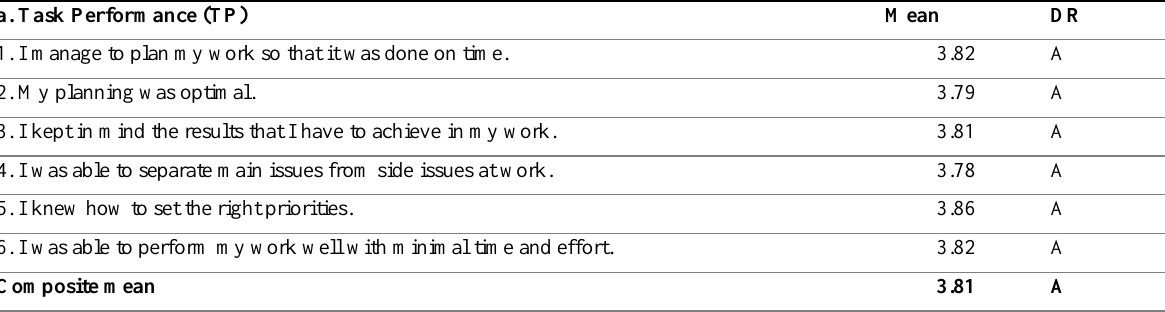
Table 3: Individual Work Performance as to Task